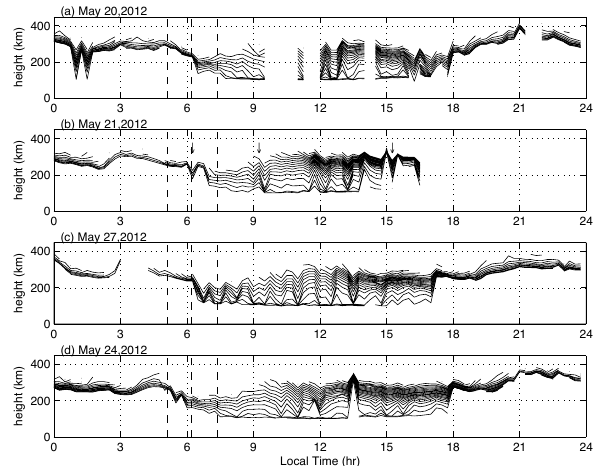
Figure 7. 3 Fig. 7. Diurnal variations in true height at fixed frequencies at Chung-Li ionosonde station on (a) 20, (b) 21, (c) 27, and (d) 24 May 2012. The vertical dashed lines represent the onset, sec- ond contact, and ending time of the annular solar eclipse on 21 May